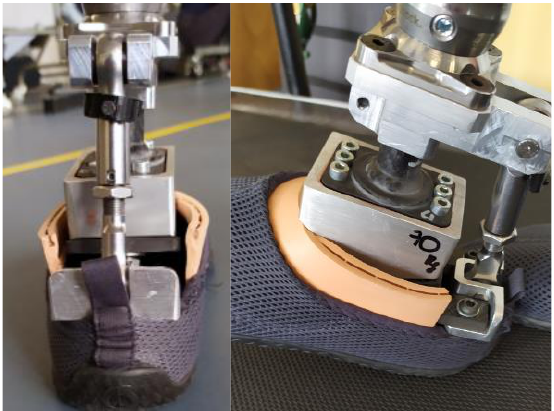
Figure 6. Comparisons among the static plantarflexion and dorsiflexion 2D FEAs and 3D FEAs and the mechanical tests on the physical prototype.